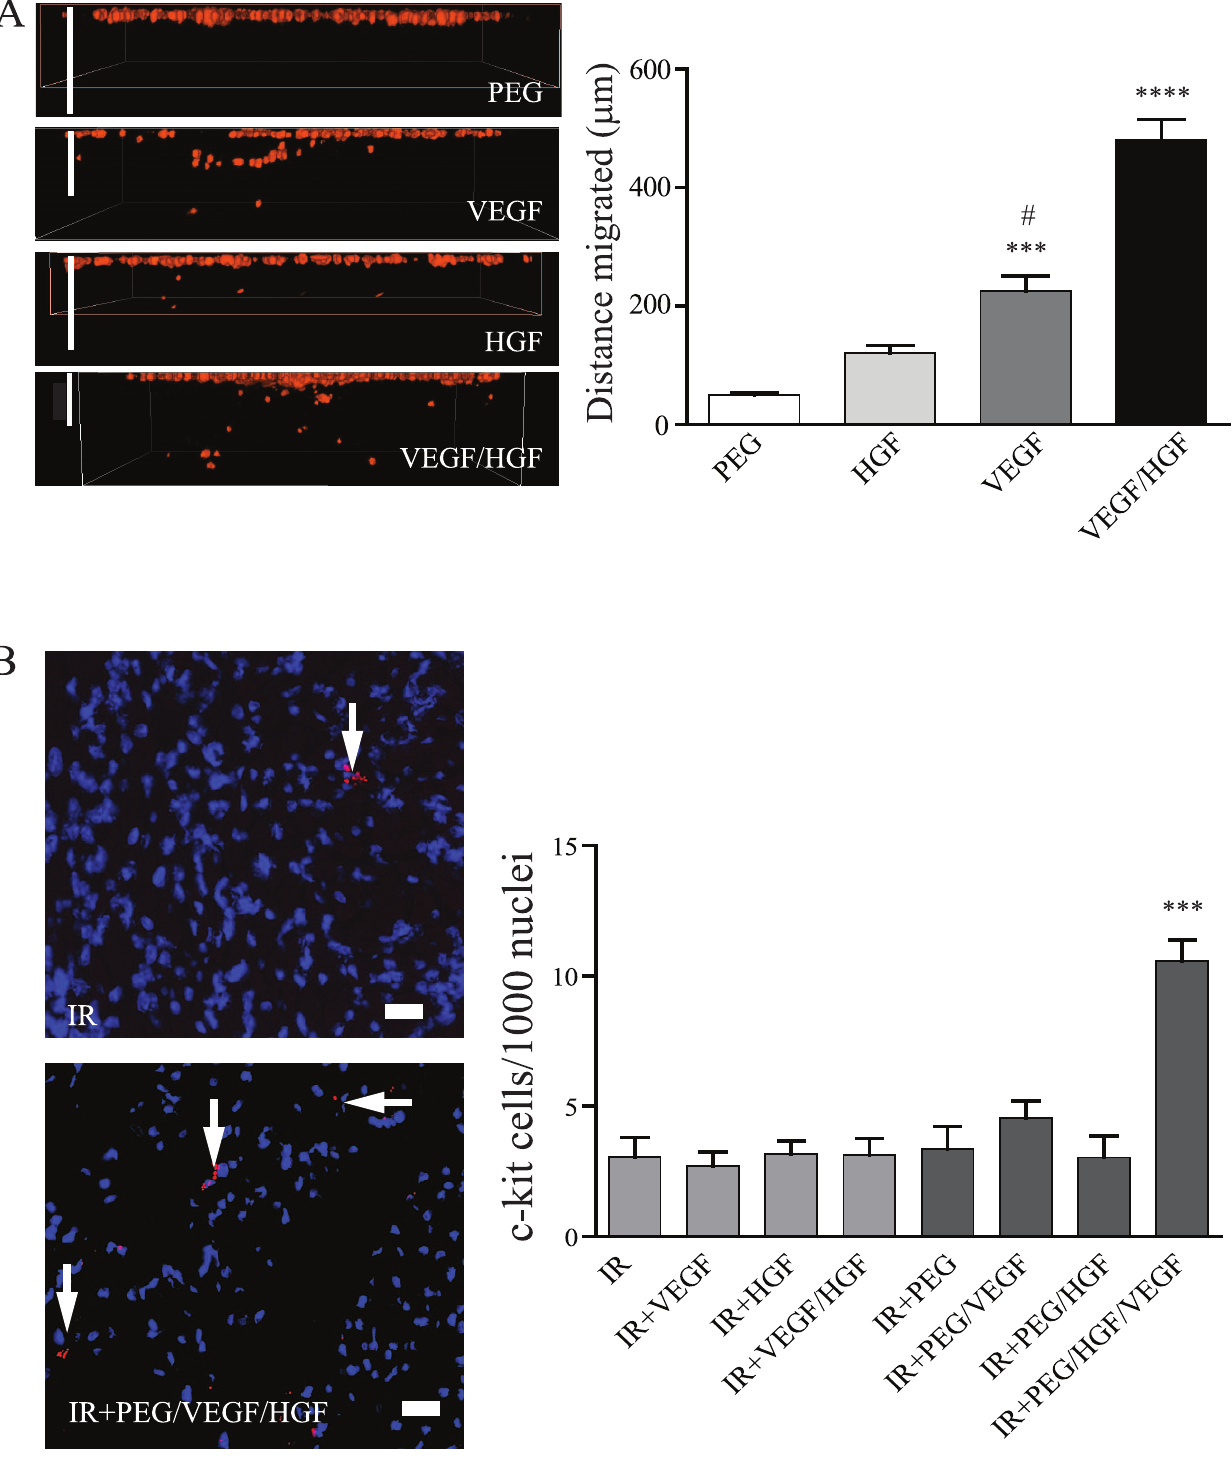
Figure 4. Progenitor cell recruitment. (A) Isolated, fluorescently-tagged cardiac progenitor cells (CPCs) were seeded on top of hydrogels containing nothing, VEGF, HGF, or HGF/VEGF and allowed to migrate for 48 hours. Gels were turned sideways and imaged using confocal microscopy and distance migrated was determined using ImageJ (scale bar=100 m m). Data are mean 6 SEM from 5 separate experiments and demonstrate a non-significant increase in migration in to HGF-loaded gels, but a significant increase in migration in to VEGF-loaded gels (***p , 0.001 compared to PEG alone, # p , 0.05 compared to HGF). There was a further increase in migration between the single treatment groups and HGF/VEGF (****p , 0.0001 vs. all groups; ANOVA followed by Student-Newman-Keuls post-test). (B) Representative images of c-kit staining (red) in the infarct zone of rats with IR alone or treated with PEG/HGF/VEGF (blue=DAPI; scale bar=30 m m). Grouped data (mean 6 SEM; n $ 7 per group) demonstrating a significant increase in c-kit + cells in PEG/HGF/VEGF treated rats compared with IR alone (***p , 0.001; ANOVA followed by Student-